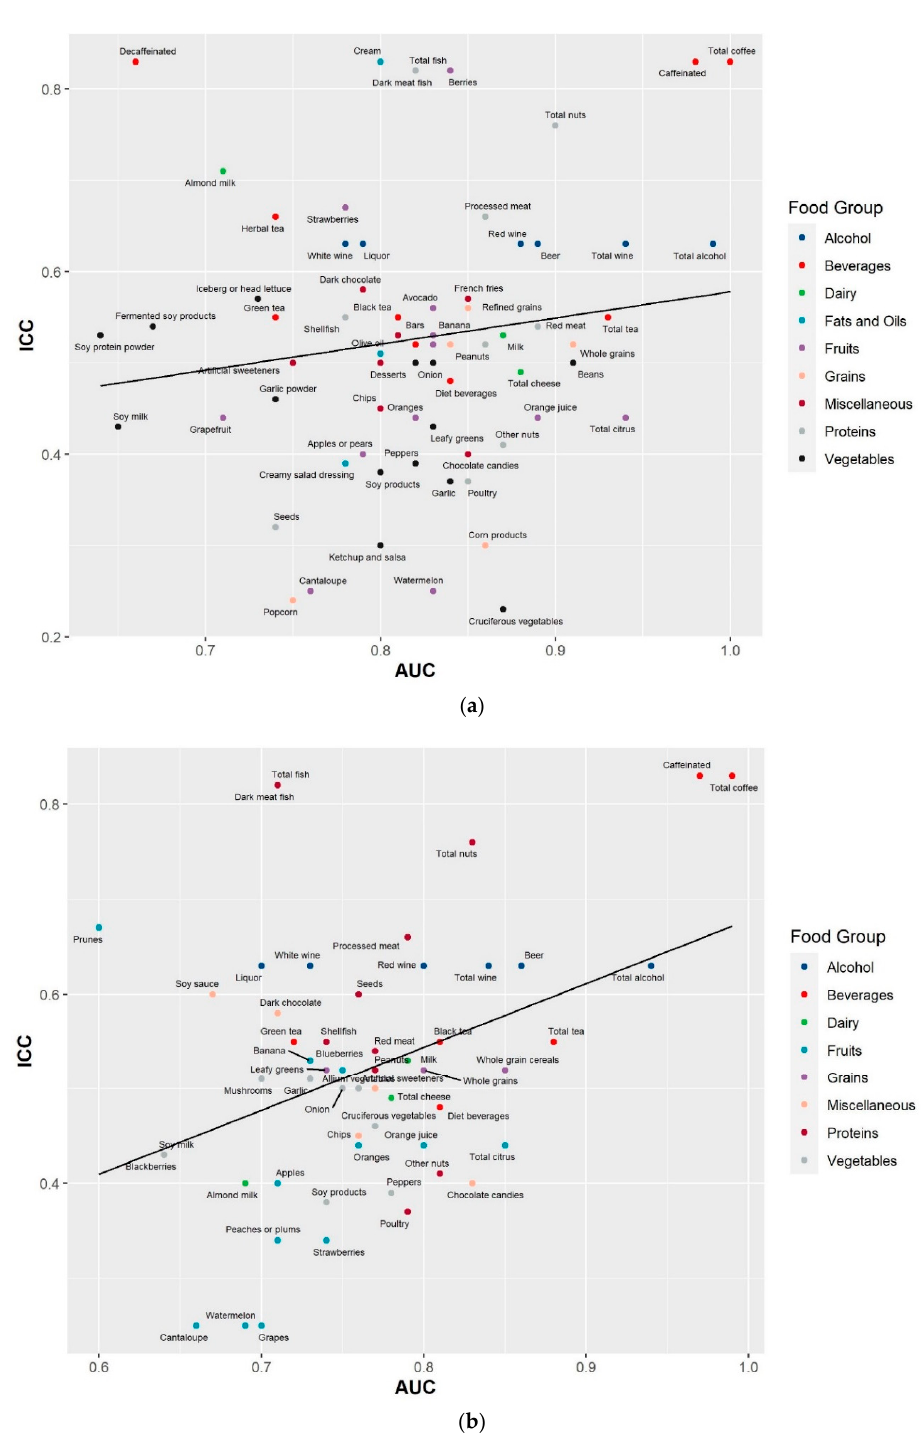
Figure 1. Metabolite prediction accuracy for food intake by metabolite reproducibility for the most predictive metabolite of 79 food groups/items in the Cancer Prevention Study-3 Diet Assessment Sub-study. ( a ) The most predictive metabolites for 71 food groups/items assessed using the food frequency questionnaire; ( b ) the most predictive metabolites for 60 food groups/items assessed using the average of 24 h diet recalls. Prediction accuracy was assessed by area under the curve (AUC) from the receiver operating characteristic curve, which indicates how well a metabolite could discriminate top quartile from bottom quartile intake of a food group/item. Reproducibility was assessed by intraclass correlation coefficients (ICCs), calculated as the ratio of between-person variance to the total variance among participants with repeated blood metabolic profiles measured six months